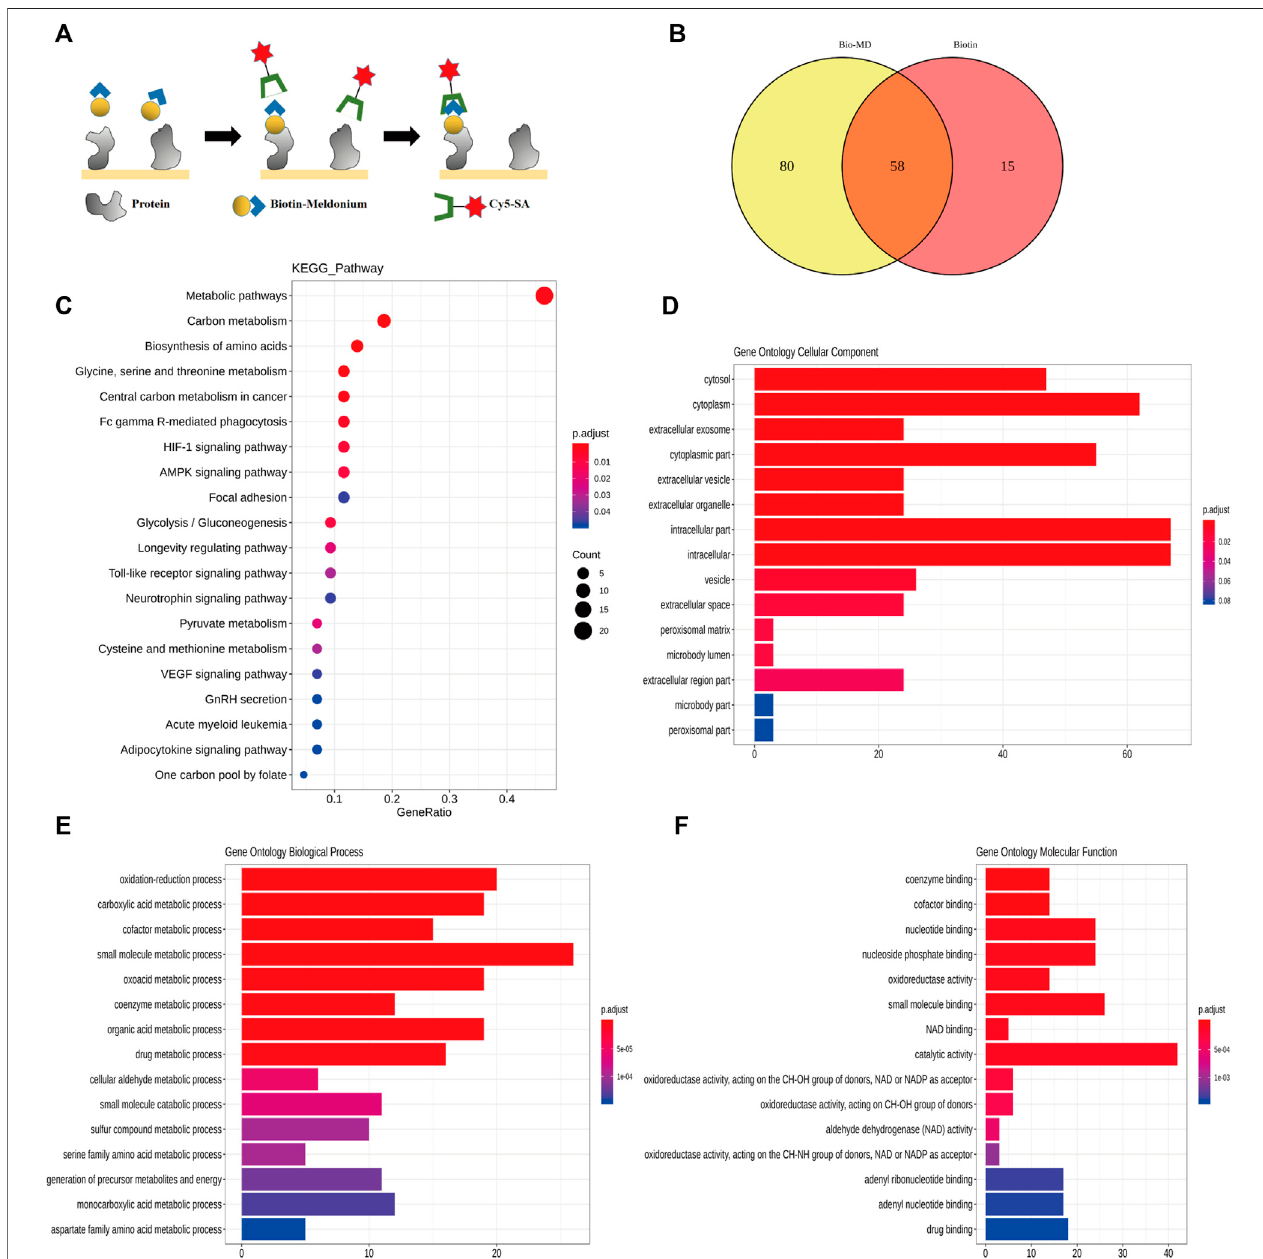
FIGURE2| Thetargetproteinsofmeldoniumarerelatedtothemetabolicpathwayasrevealedusingthehumanproteomemicroarrayanalysis. (A) Schematicofthe procedureusedtodetectbiotin-meldoniumbindingproteins. (B) Vennmapofthepositivespotsformeldoniumandbiotintargetproteins. Thenumberintheyellowarea representsthenumberofmeldonium-speci fi ctargetproteins.MD:meldonium. (C) Top20enrichedpathwaysofmeldoniumtargetproteins. (D) Top20enrichedcellular components of meldonium target proteins. (E) Top 20 enriched biological processes of meldonium target proteins. (F) Top 20 enriched molecular functions of meldonium target